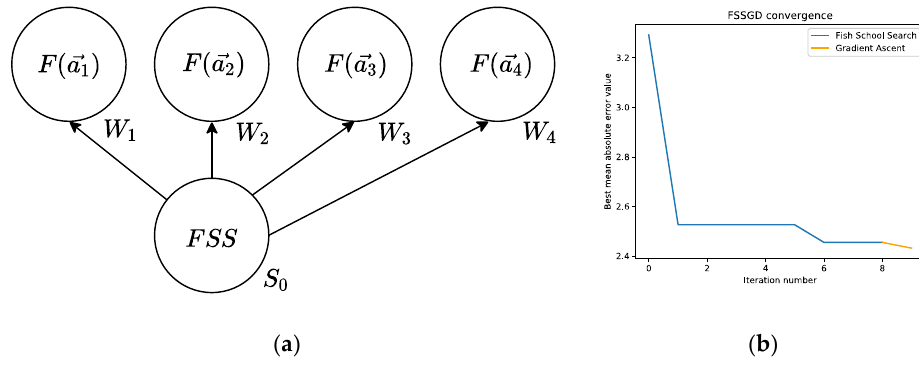
Figure 5. ( a ) Network topology for the distributed version of the FSS algorithm. Here, (cid:1853)⃗ (cid:3036) denotes the (cid:1861) - i -th agent; F is the time-consuming fitness function; W i is the i -th worker; S 0 is the server, which hosts th agent; (cid:1832) is the time-consuming fitness function; (cid:1849) (cid:3036) is the (cid:1861) -th worker; (cid:1845) (cid:2868) is the server, which hosts the algorithm; ( b ) FSSGD algorithm convergence when optimizing the algorithm; ( b ) FSSGD algorithm convergence when optimizing hyperparameters.